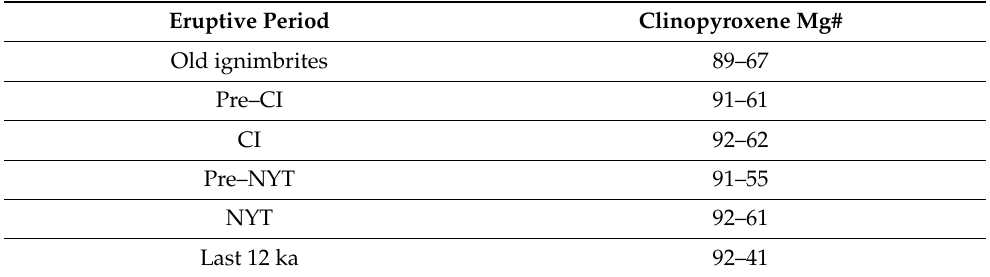
Table 1. Ranges of Mg# values of clinopyroxene crystals belonging to different periods of Campi Flegrei